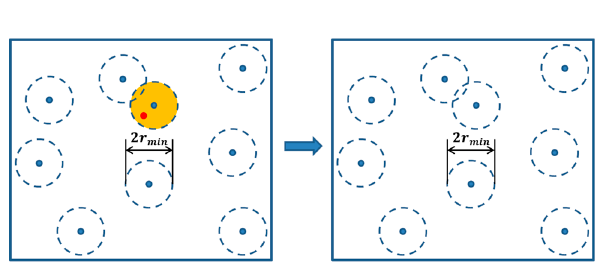
Figure 5. Implementation of point seeders.